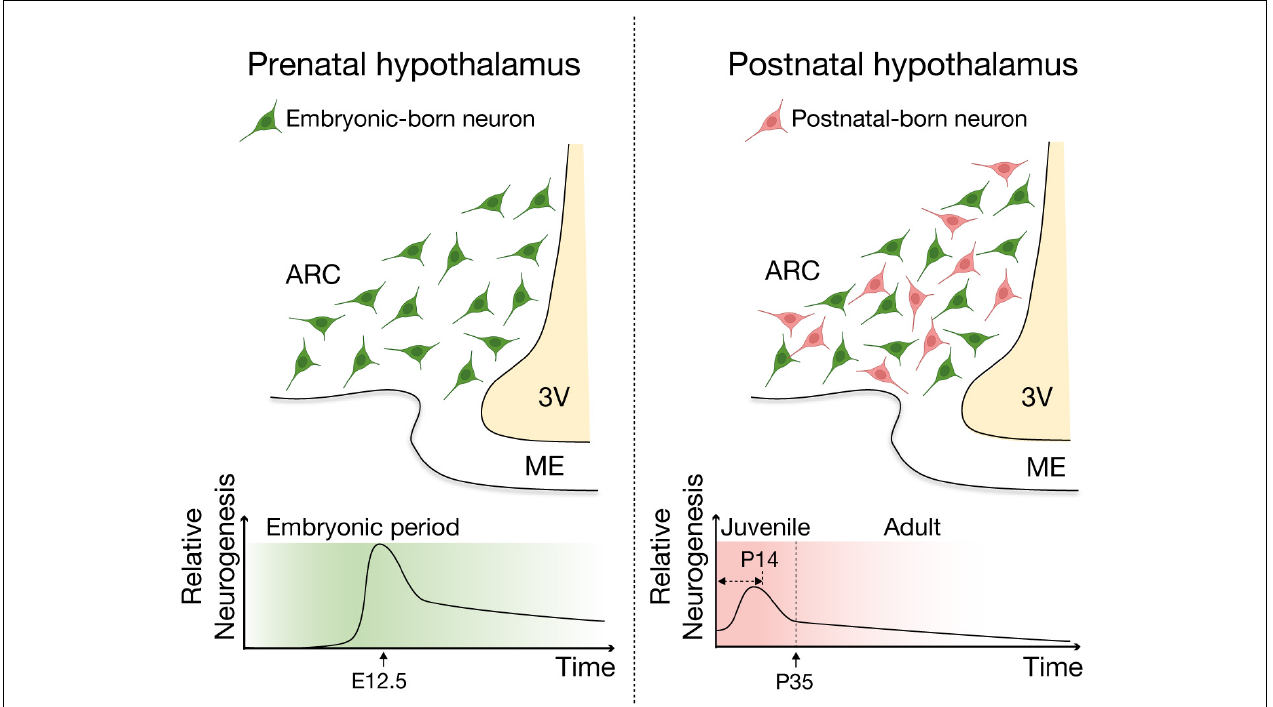
FIGURE 3 | Schematic of embryonic and postnatal neurogenesis in the ARC-ME of the hypothalamus. Two major waves of neurogenesis have been reported in the hypothalamus. In mice, the neurogenic period of the developing hypothalamus encompasses embryonic day (E) 10 to E16, with a peak of neurogenesis at around E12.5. A second wave of neurogenesis is detected during the juvenile stages, especially within the first two postnatal weeks and continues throughout adulthood and contributes remodeling of the hypothalamic neuronal circuit. This figure was adapted from Son et al. (2021a) with